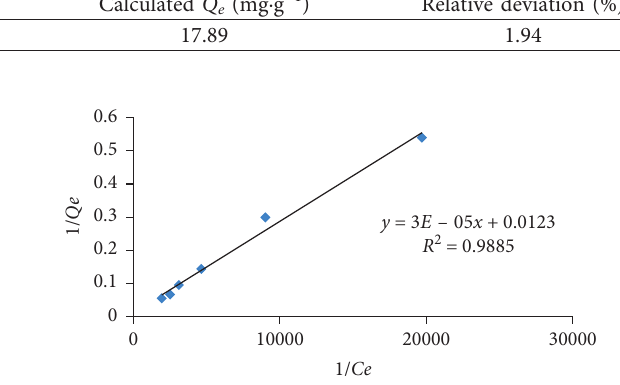
Figure 11: Adsorption isotherm of phenol on Sale clay, Langmuir